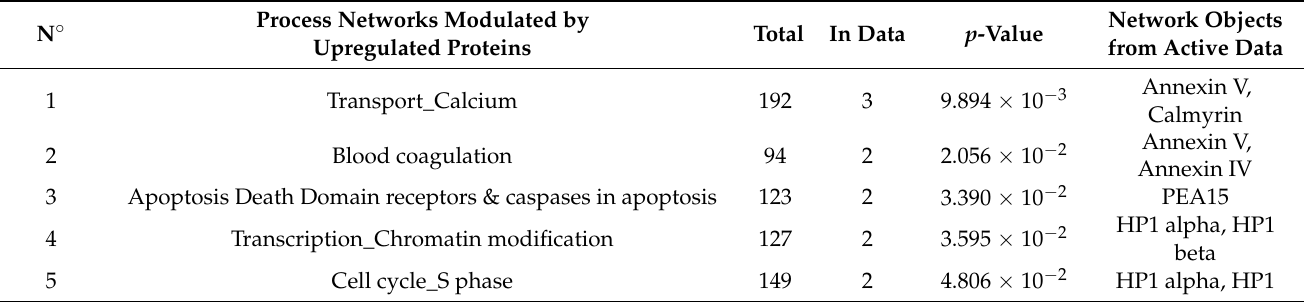
Table 4. MetaCore enrichment analysis of proteomics data in LNCaP PCa cells overexpressing miR-423-5p. Significant process networks modulated by upregulated proteins in LNCaP PCa cells expressing miR-423-5p mimic compared to control (empty vector) ( p -value ≤ 0.05). Quantitative SWATH-mass spectrometry data analysis performed with the SCIEX OneOmics cloud processing platform (n = 6 biological replicates).